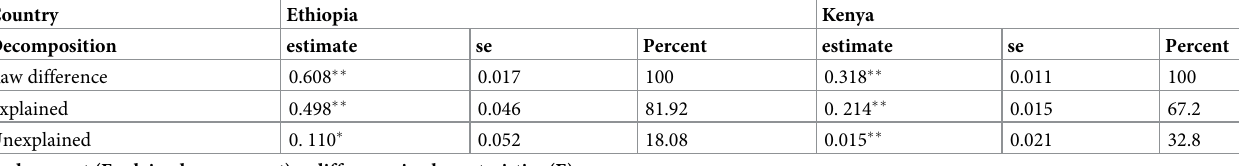
Table 3. Detailed decomposition of institutional delivery by place of residence for Ethiopian and Kenyan women.